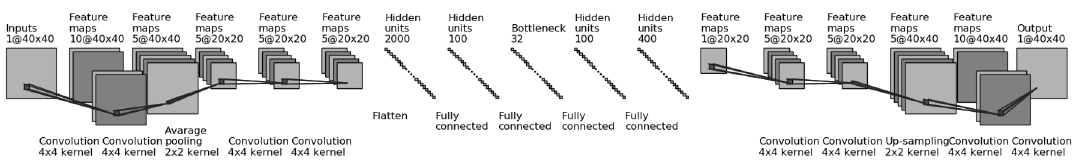
Figure 1 . Average of 40k QCD (left) and top jet images (right) in the test dataset, according to the standard preprocessing as described in appendix A.